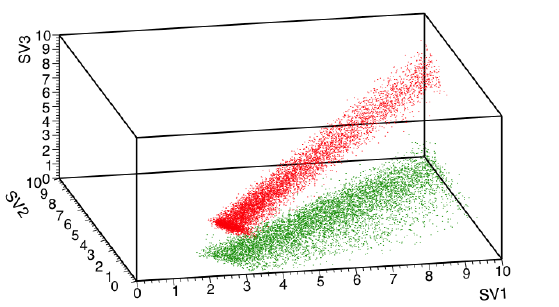
Figure 1. Decomposition in singular values SV1, SV2, and SV3 of the hit distribution in the detector for neutrinos (green, band in SV1-SV2 plane) and background (red, band with pronounced SV3 component) as described in the text. The neutrino signals can be e ff ectively discriminated from the background with a cut on the SV3 parameter (spread of data points in direction perpendicular to the fitted